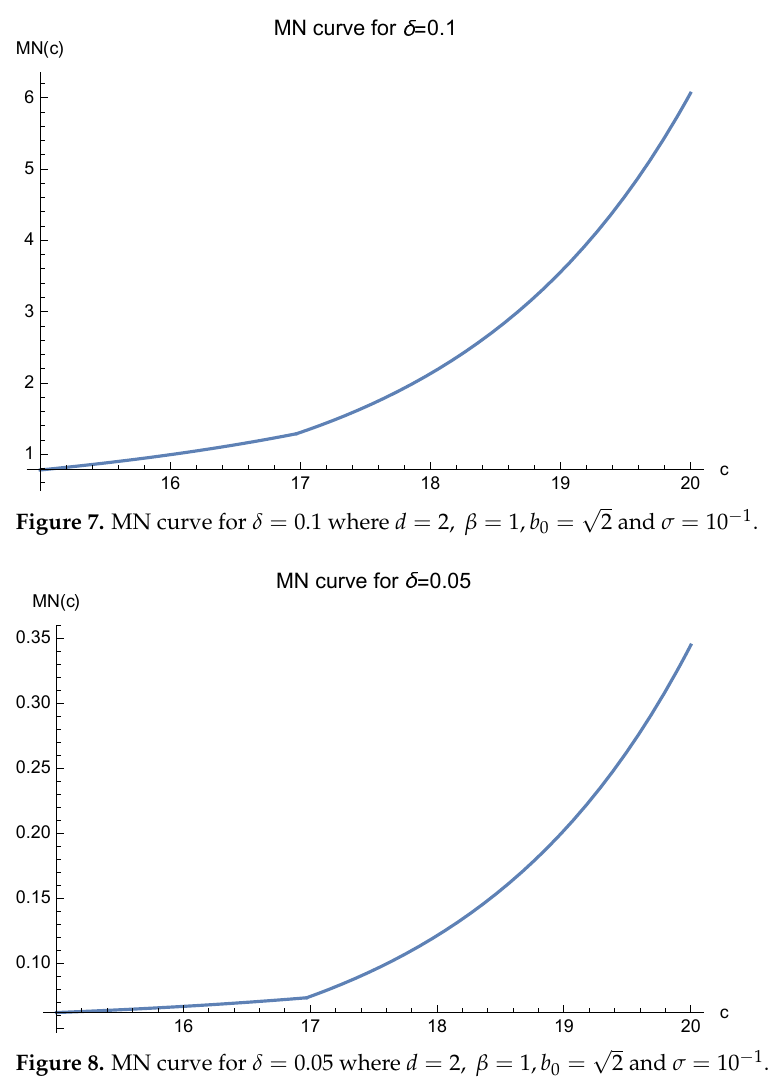
Figure 8. MN curve for δ = 0.05 where d = 2, β = 1, b 0 =